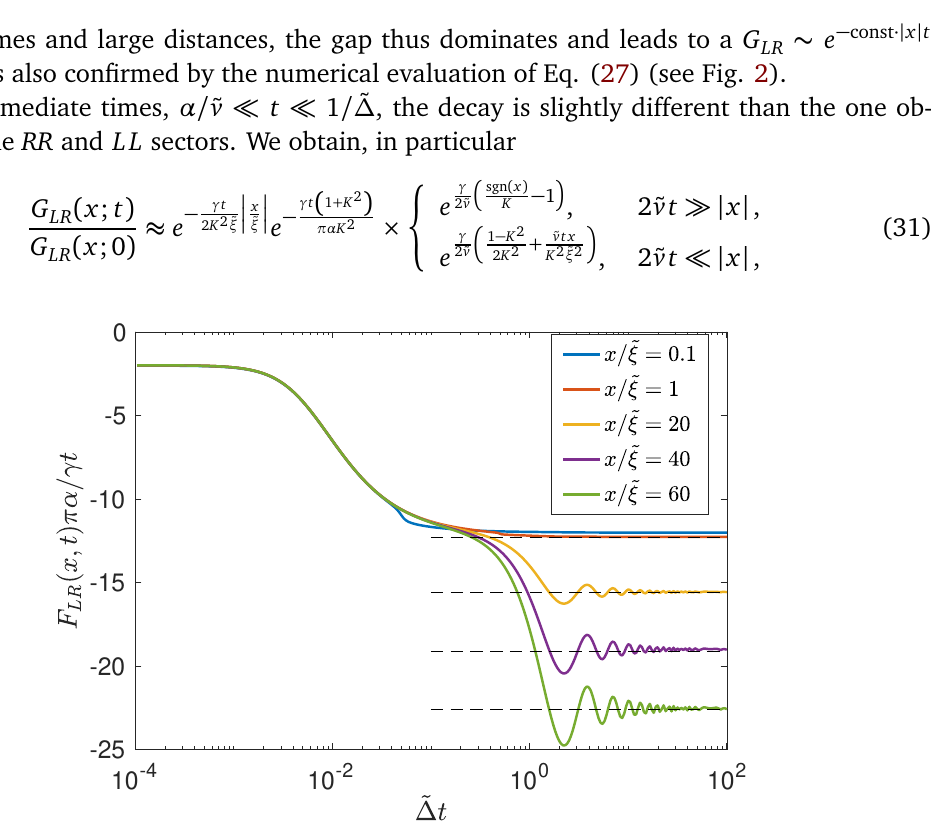
Figure 2: Time dependence of the decay rate of the anomalous LR single particle den- sity matrix, governing the amplitude of 2 k charge density wave correlations. The F curves are obtained by evaluating Eq. (27) numerically with K = 0.3 and α/ ˜ ξ = 0.01. Short and long time asymptotics are very similar to those of the RR sector (see in Fig. 1). The crossover is described by Eq.